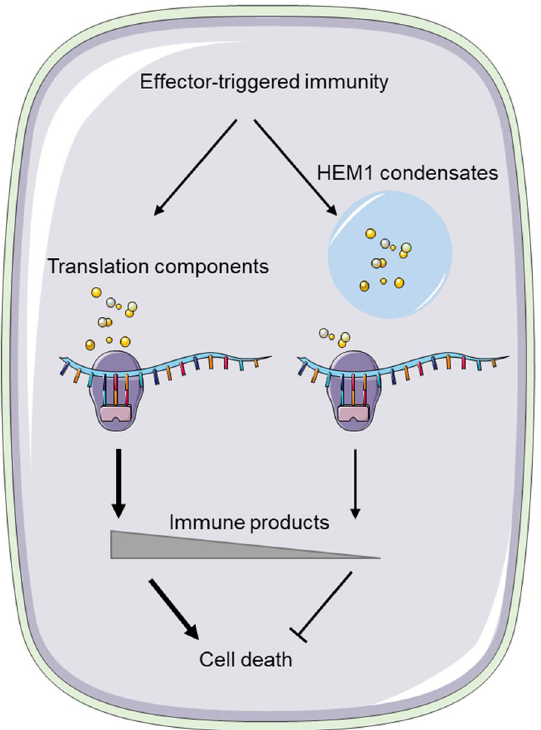
Fig. 1 ETI-induced HEM1 condensates sequester translational components to inhibit immune gene translation and to promote cell survival. During effector triggered immunity (ETI), plants massively reprogram the translatome to produce immune gene products to restrict pathogen growth through programmed cell death. Zhou et al. found that ETI activation induces HEM1, a low complexity domain-containing protein, to form cytoplasmic biomolecular condensates through biological phase separation that sequester translation factors to promote cell survival and tissue